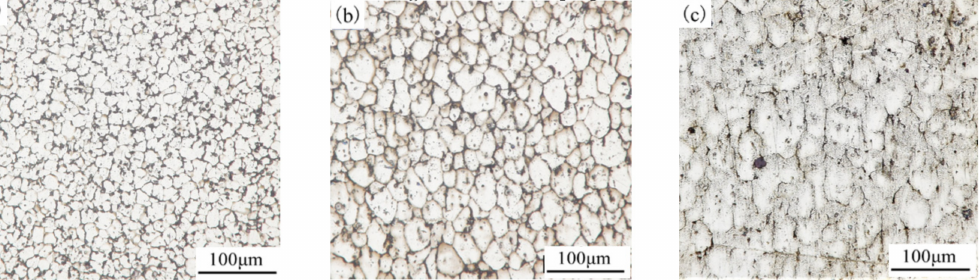
Figure 6. Grain microstructure at different locations of the deposited layer fabricated using welding current of 180 A. ( a ) Grain microstructure at the top of the layer. ( b ) Grain microstructure in the middle of the layer. ( c ) Grain microstructure at the bottom of the layer.